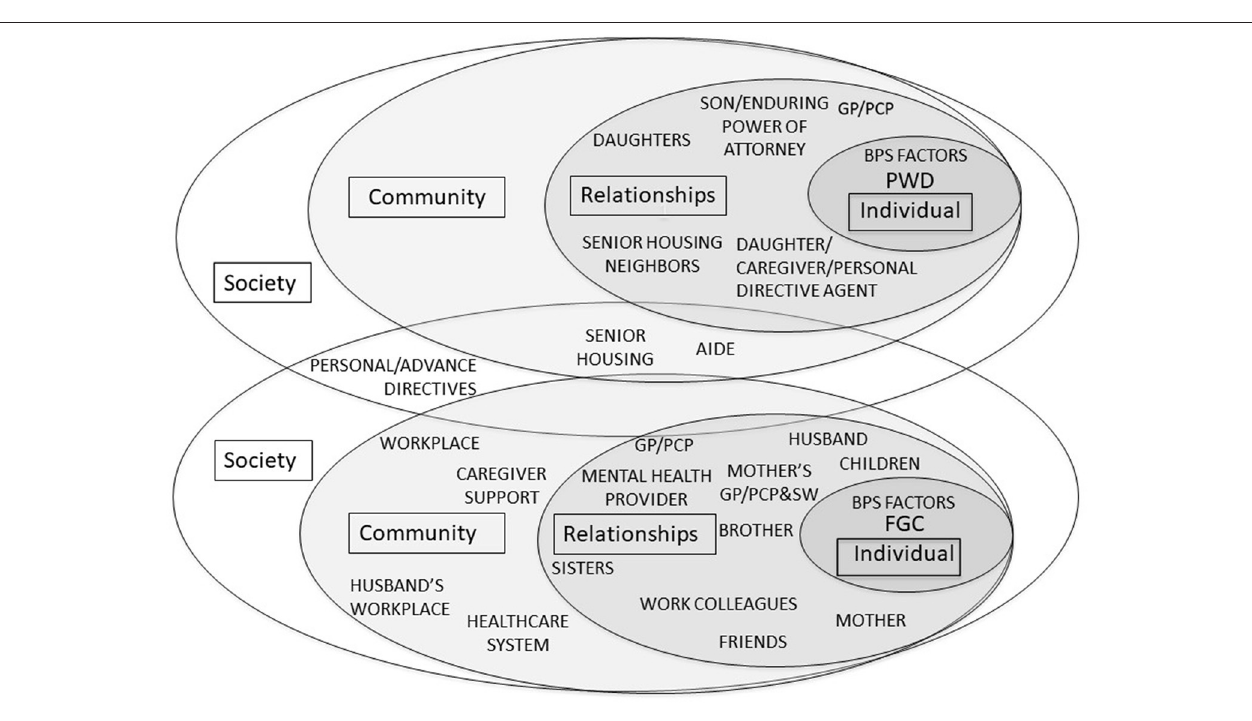
FIGURE 2 | Biopsychosocial-Ecological Approach to Patient-Centered and Caregiver-Centered Dementia